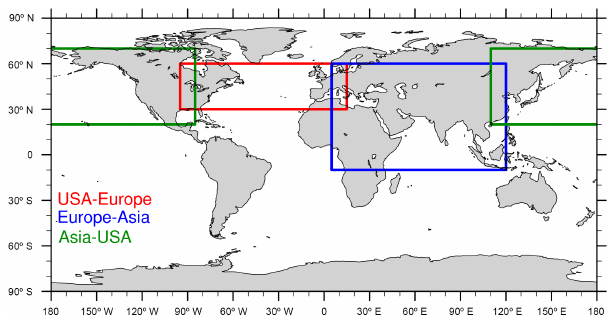
Figure 1. The regions selected for the analysis of the aviation im-